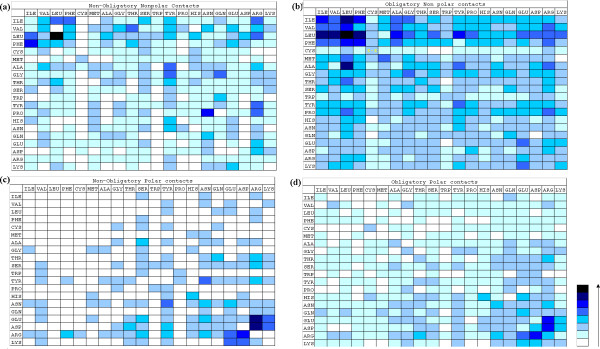
Residue contact matrix showing the frequency of the contact between two residues at the interface. a: Non-obligatory non-polar interactions, b: obligatory non-polar interactions c: non-obligatory polar interactions d: obligatory polar interactions. The residues contributed by the obligatory or non-obligatory chain of the complex is represented in rows. The residues from the partner chain (for which the assignment of obligatory or non-obligatory is ambiguous) is shown in columns. Colour gradation: white- No interaction; Cyan to black- increasing gradation of interaction with normalised frequency varying between 0–14 in discrete steps.